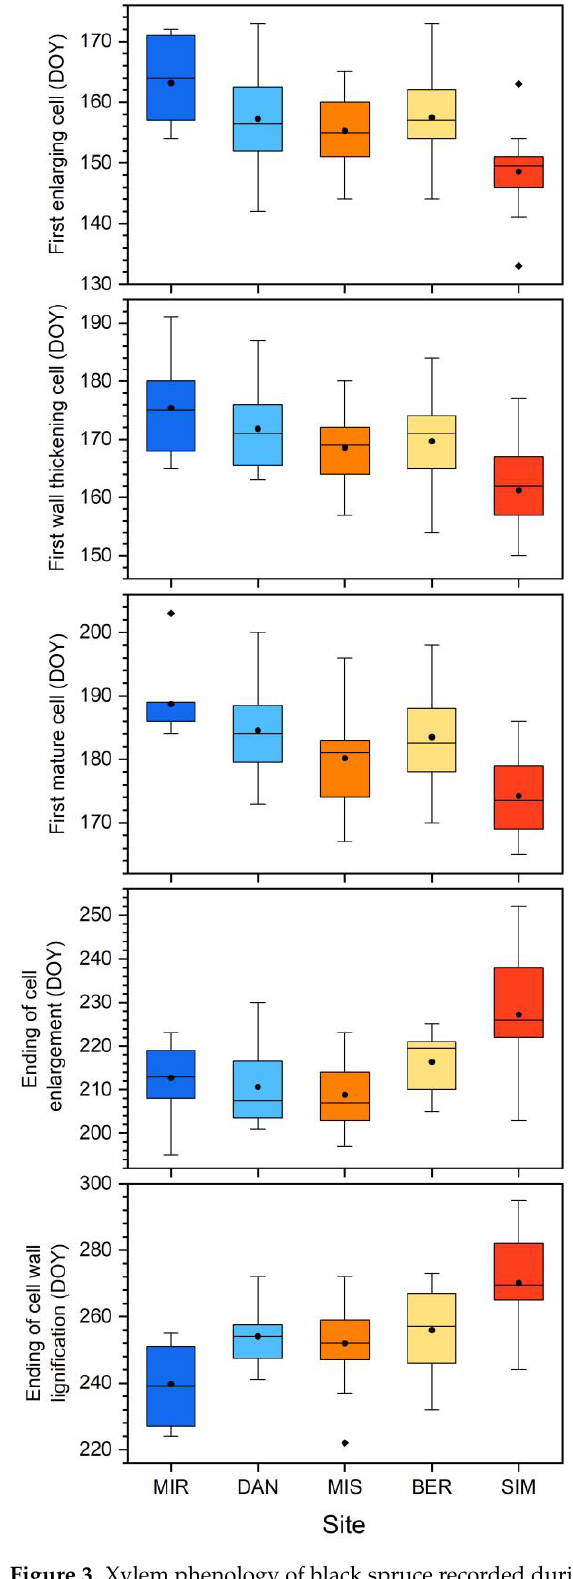
Figure 3. Xylem phenology of black spruce recorded during 2002 – 2019 at five permanent sites in the boreal forest of Quebec, Canada. The sites are listed at decreasing latitude. Lower and upper box limits represent the first and third quartiles, horizontal black lines represent median values, black dots represent mean values, whiskers represent 1.5× the interquartile range, and black diamonds represent outliers.